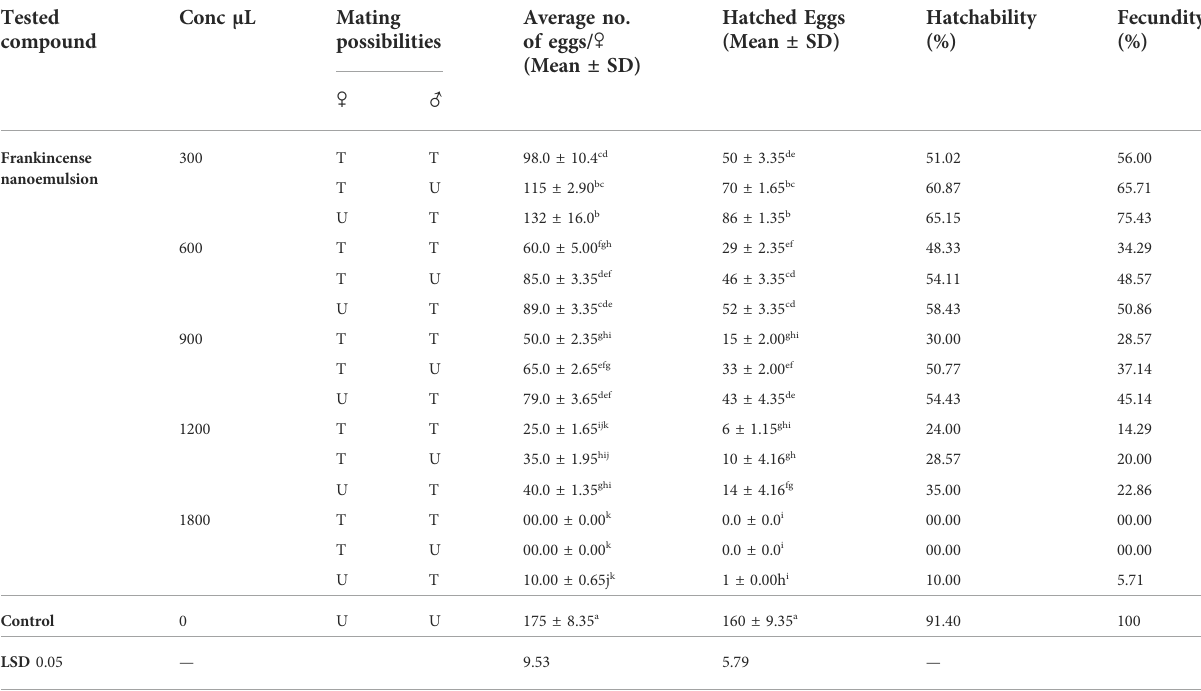
TABLE 4 Latent effect of frankincense nanoemulsion and combination between male and female adults on total eggs laid and hatchability percentages of E. insulana under laboratory conditions. Tested